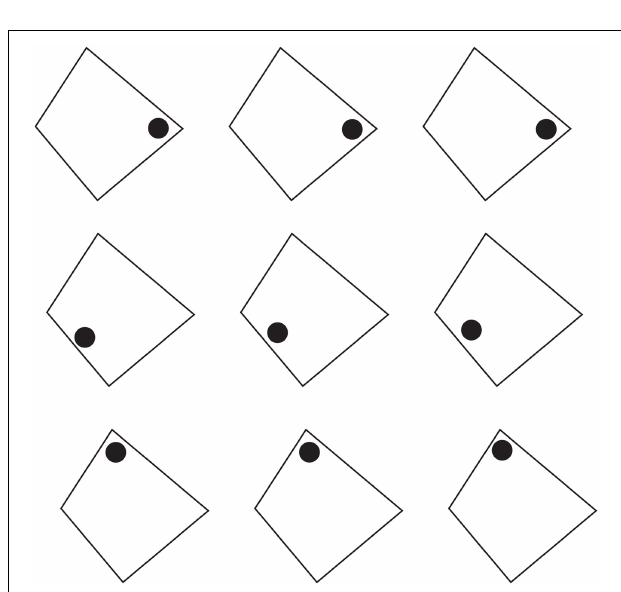
FIGURE 9 | The same figures, accentuated by black dots in different positions, are perceived as different irregular shapes.